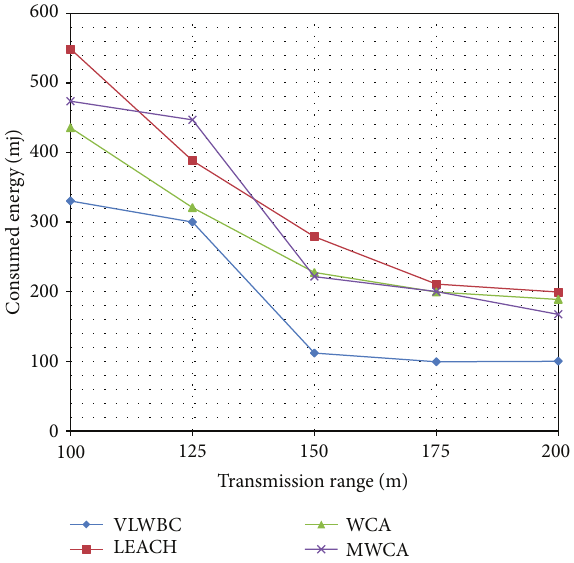
Figure 5: Consumed energy with increase in transmission rate. Table 3: Comparison of lifetime factors for proposed algorithm. Algorithm